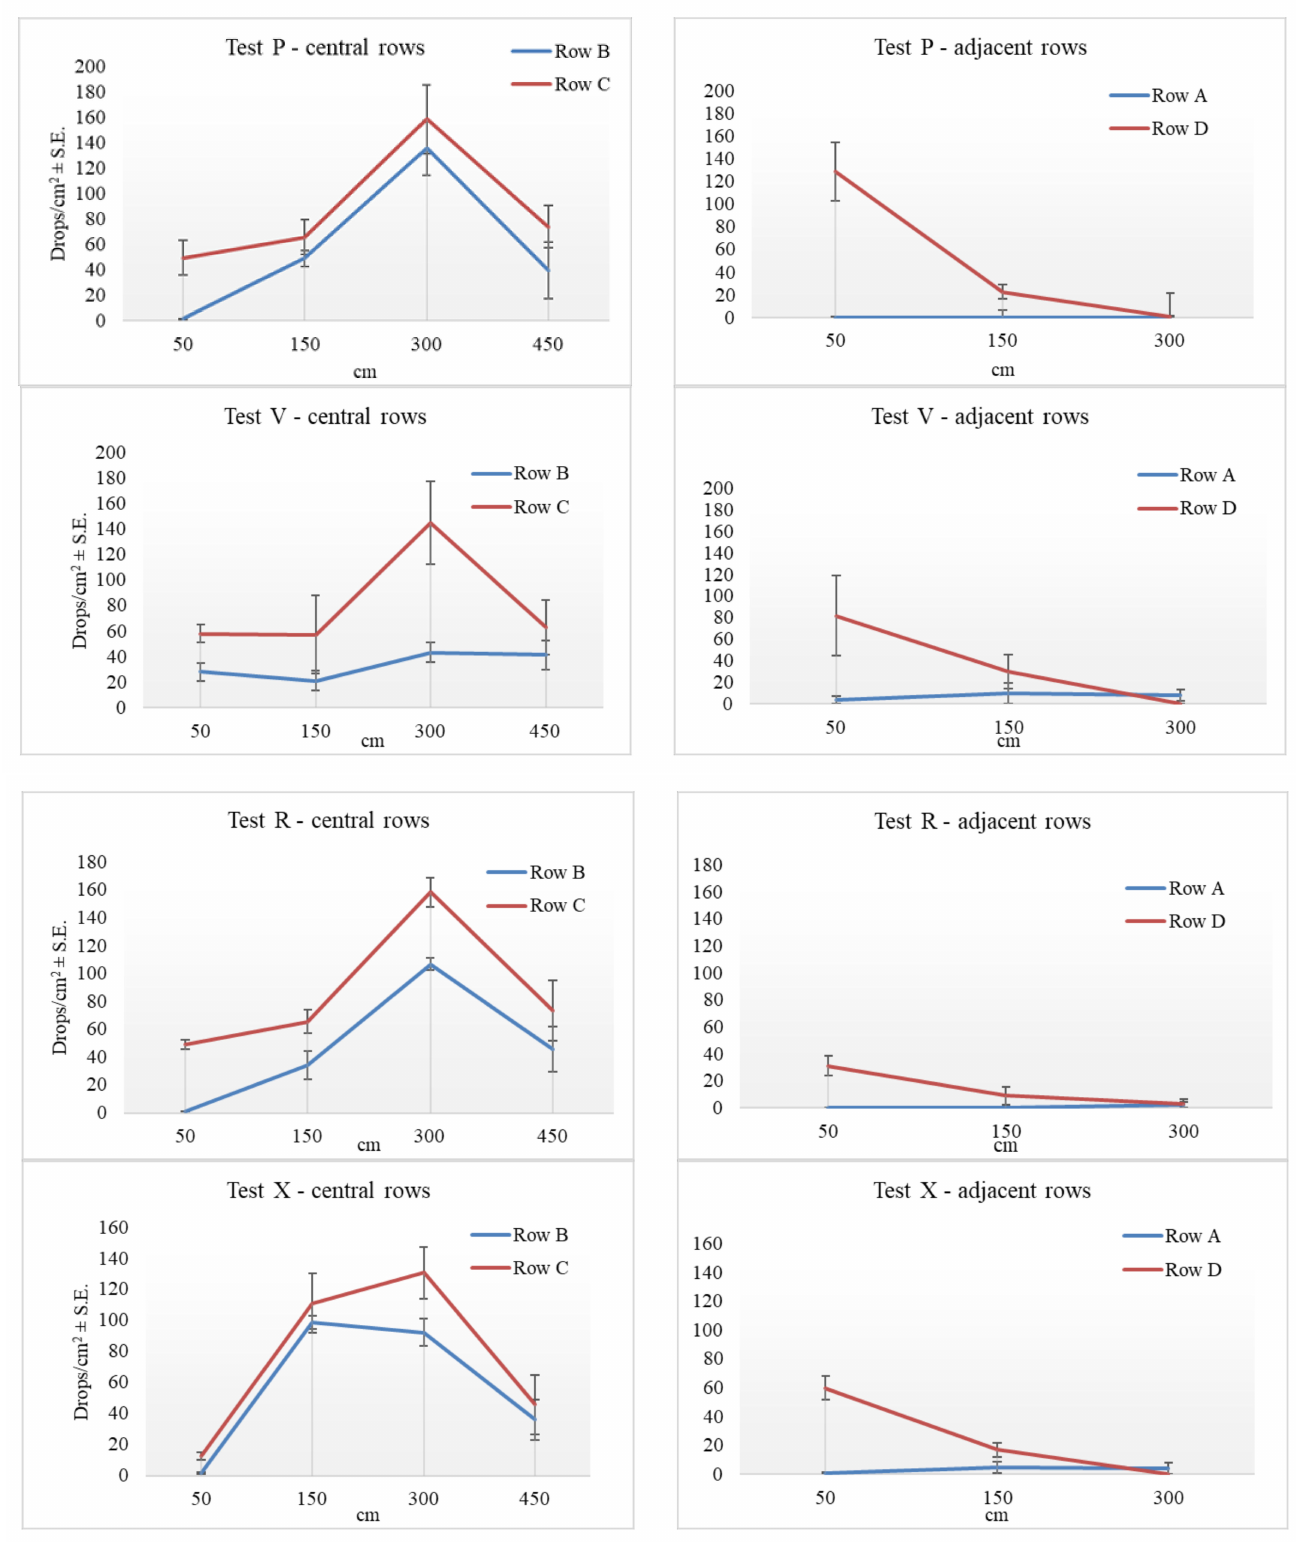
Figure 6. Average values ± standard error of the number of droplets per cm 2 collected on WSP by the four sprayer configurations. The figures show the values for the central rows (B and C) on the left and the values for adjacent rows (A and D) on the